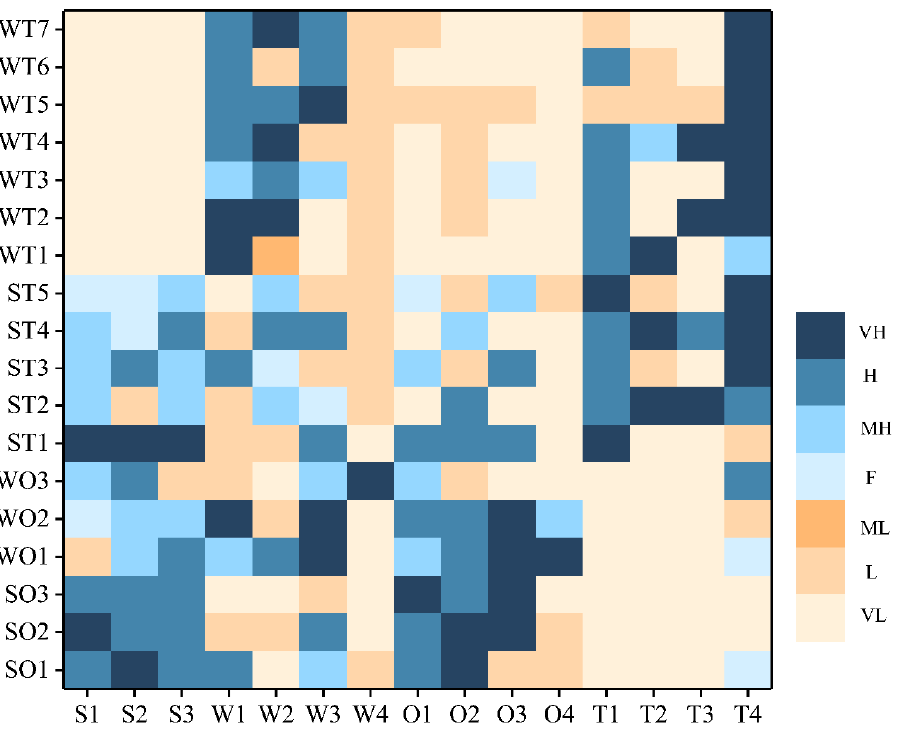
Figure 5. The evaluation matrix for TOPSIS method. Table 3. The priority ranking of strategies using fuzzy TOPSIS.